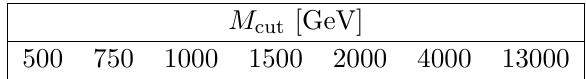
table 1 and for seven values of M cut : M cut [GeV] 500 750 1000 1500 2000 4000